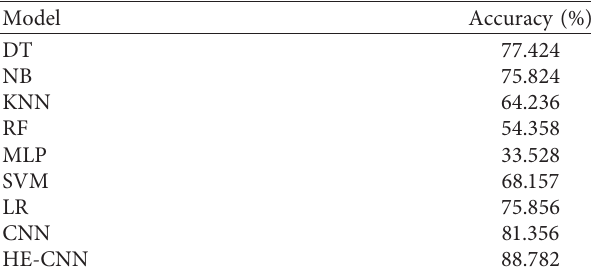
Table 6: Classification performance of different models on our HE dataset with text features.